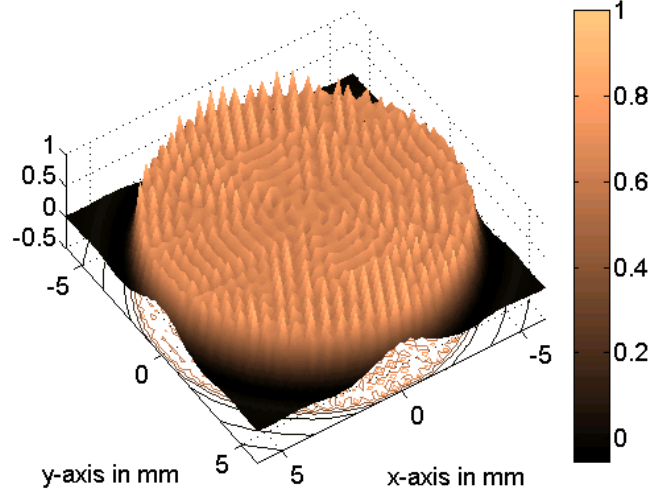
Figure 2. Normal velocity on the transducer face computed by the DPSM (distributed point source method) technique when point sources, as shown in Figure 1, are used to model the transducer face.